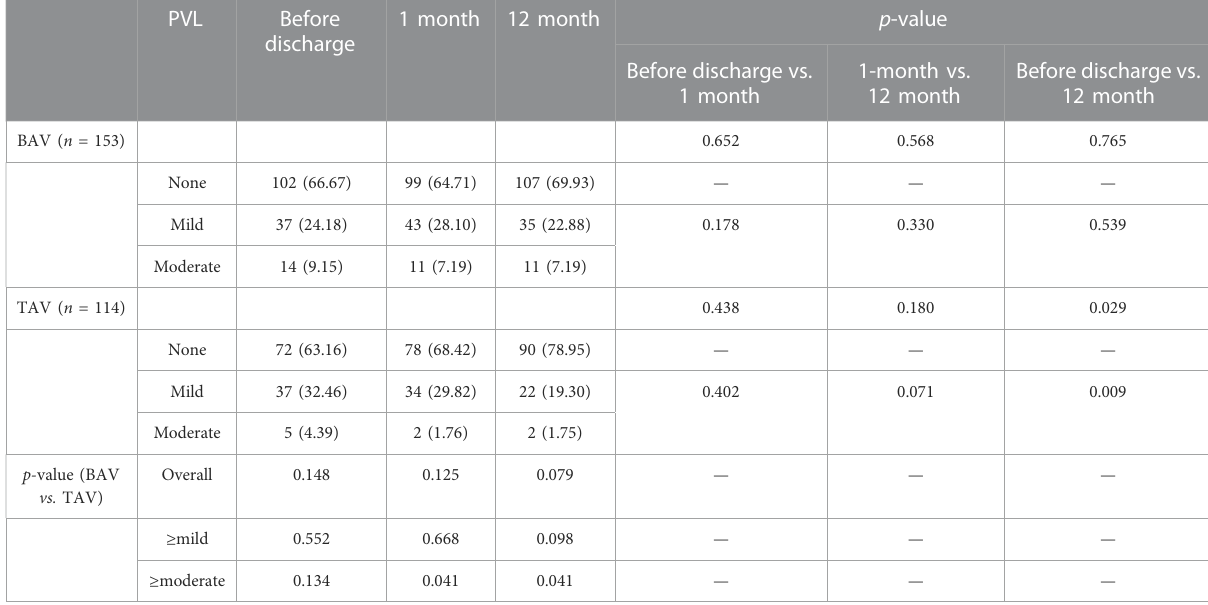
PVL, paravalvular leak; other abbreviations are shown as previously mentioned.